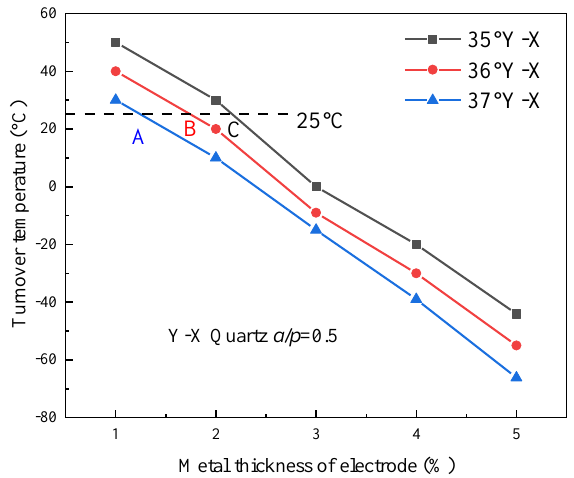
Figure 5. Turnover temperature of quartz with different cut angles and IDT with the electrode thickness.